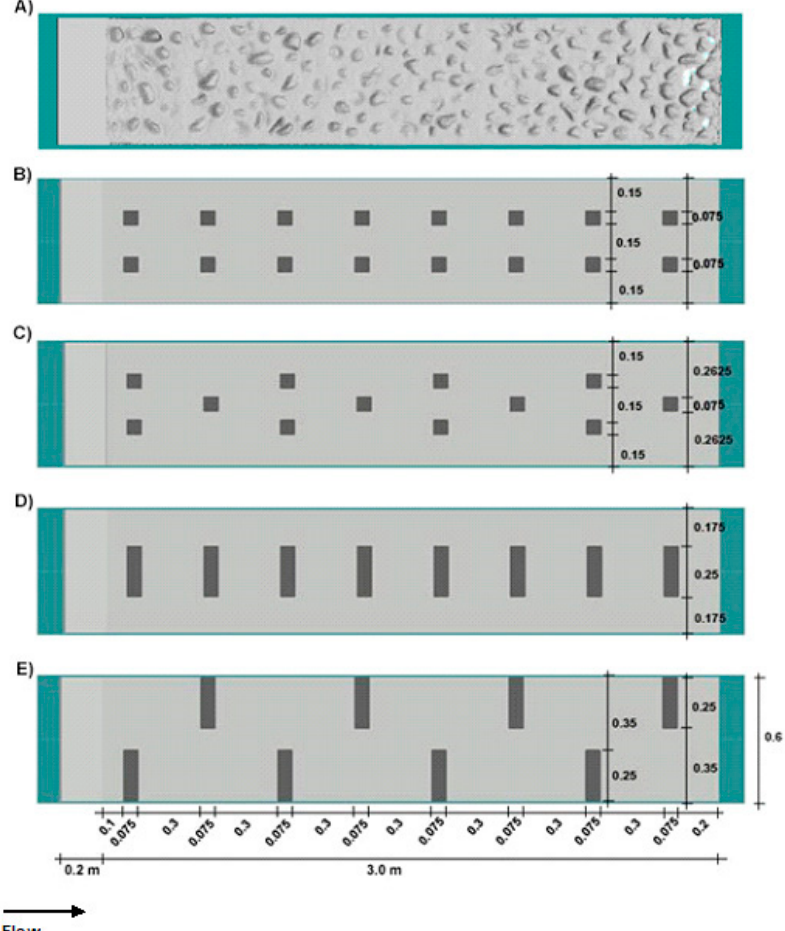
Figure 2. Scheme of the substrates arrangement for the retrofitted designs (RD), showing flow direction and the 0.2 m weir crest: ( A ) Nature (the mapping of cobbles along the ramp was done using a Kinect Sensor); ( B ) Small Boulders Aligned; ( C ) Small Boulders Offset; ( D ) Large Boulders Aligned; ( E ) Large Boulders Offset. Substrates dimensions: Cobbles—10 to 30 cm; Small Boulders—7.5 cm long × 7.5 cm wide × 15 cm high; Large Boulders—25 cm long × 7.5 cm wide × 30 cm high. 2.2. Fish Capture and Holding